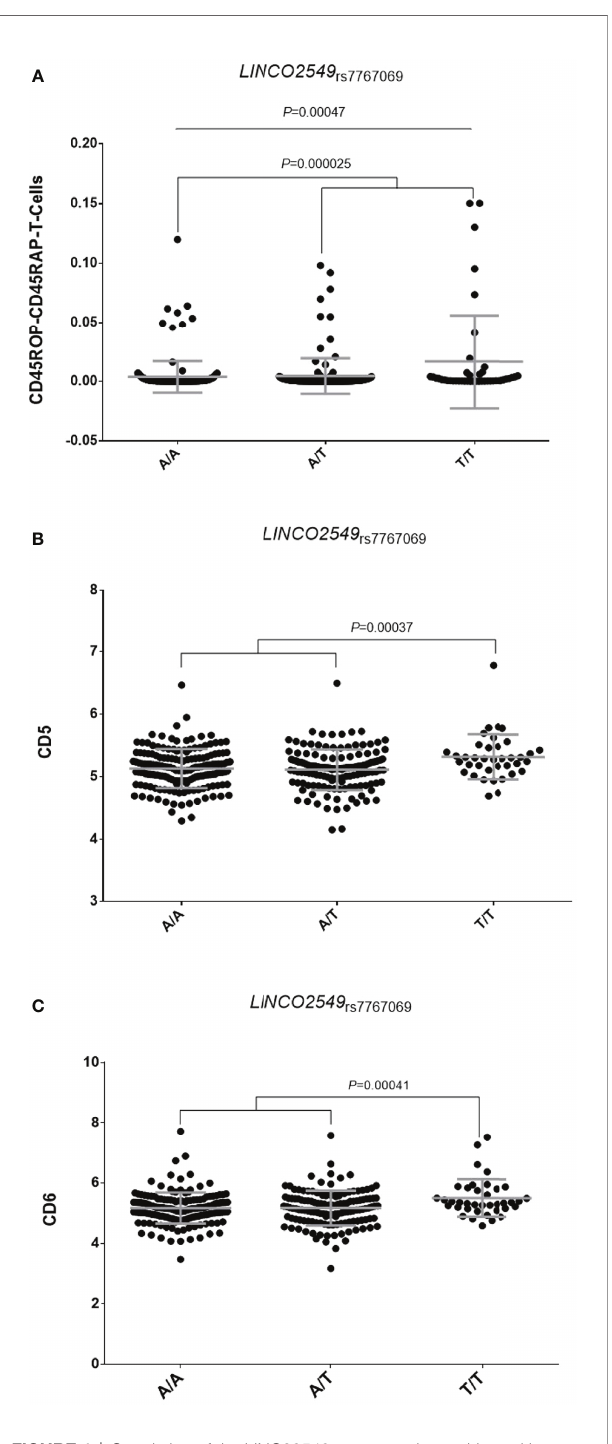
FIGURE 1 | Correlation of the LINC02549 rs7767069 polymorphism with absolute numbers of CD45RO+CD45RA+ T cells in blood (A) and serum levels of soluble scavenger receptors CD5 (B) and CD6 (C) .